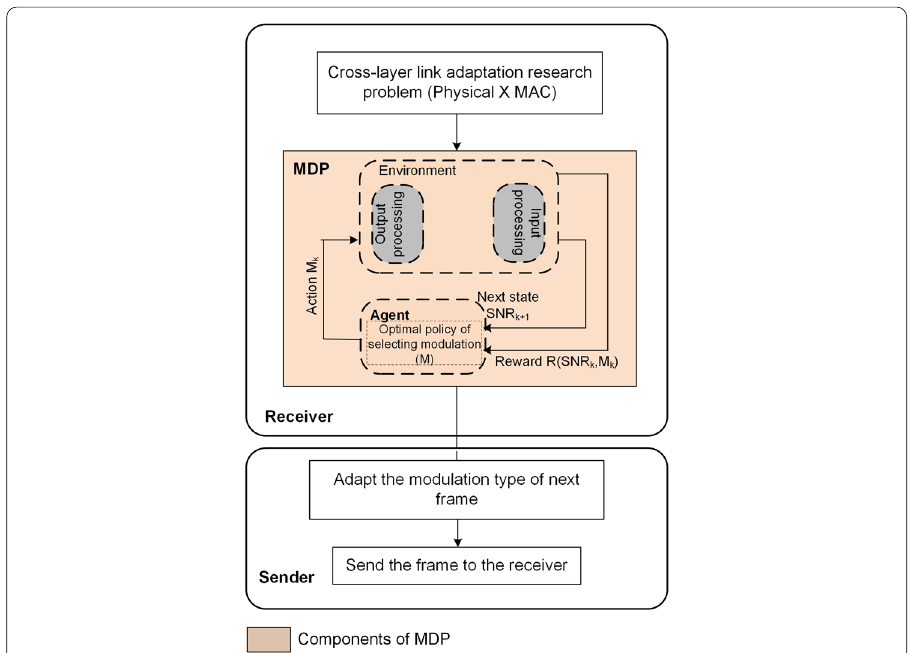
Fig. 4 Process flow of proposed MDP‑CLLA link adaptation and reception scheme